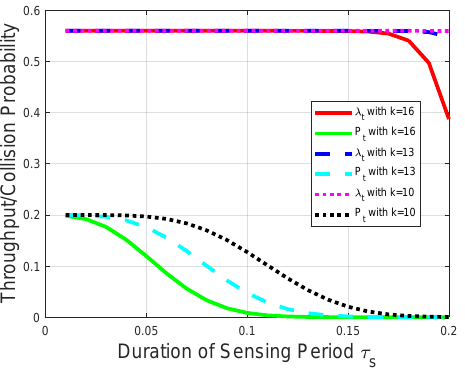
Figure 7. Throughput and collision performances of the CRN with a given transmission period when τ s is relatively